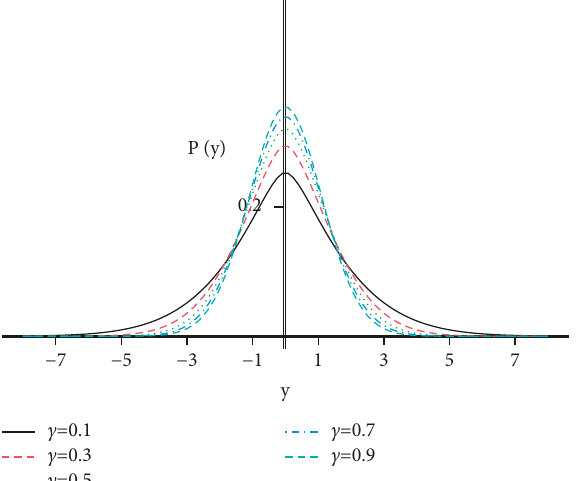
Figure 7: Plots the distribution of β with different values of c and; ζ � 0 . 5, and μ � 4.